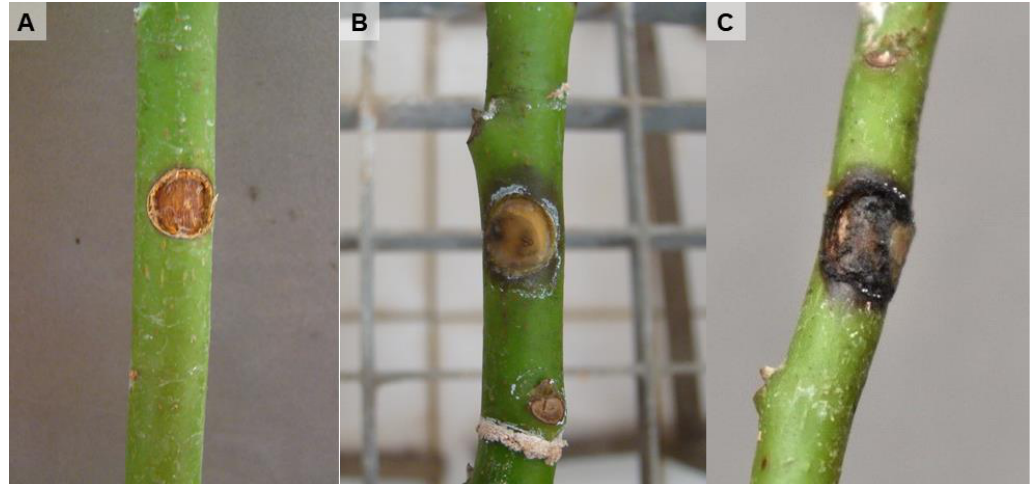
Figure 5. External symptoms in Topa Topa avocado seedlings 3 months after inoculation. Plants were inoculated by inserting a mycelial plug in a wound made in the stem at 5 cm from the ground. ( A ), negative control (plants inoculated with a fungus-free agar fragment); ( B , C ), damage caused by isolate B161 of Lasiodiplodia brasiliensis .